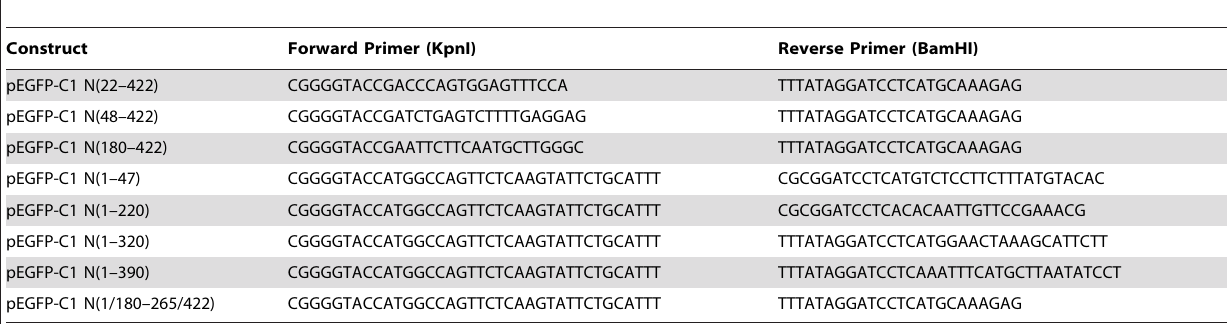
Table 2. Oligonucleotides used for the construction of the GFP fused truncated N